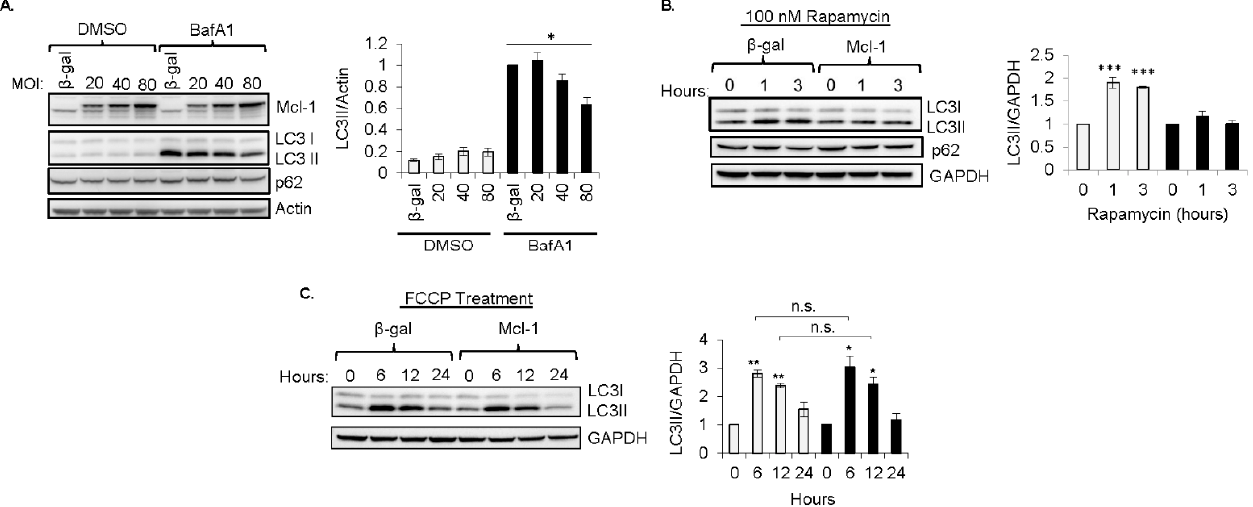
Figure 3. Mcl-1 overexpression inhibits induction of nonselective, but not selective, autophagy. ( A ) LC3II levels accumulate in cells overexpressing β -gal or Mcl-1 (at 20, 40, or 80 multiples of infection (MOI)) in the presence of 50 nM Bafilomycin A1 for 4 h ( n = 4). ( B ) Representative blot and quantification of LCII levels in MEFs treated with 100 nM Rapamycin for 0, 1, or 3 h ( n = 3). ( C ) Representative Western blot and quantification of LC3II levels in MEFs in response to 0, 6, 12, or 24 h of treatment with FCCP (25 μ M, n = 3). * p < 0.05, ** p < 0.01, *** p < 0.0001 vs. 0 h. n.s., not significant. Data are mean ± SEM. Statistical test: ANOVA, followed by Dunnett’s or Bonferroni’s multiple com- parison test.